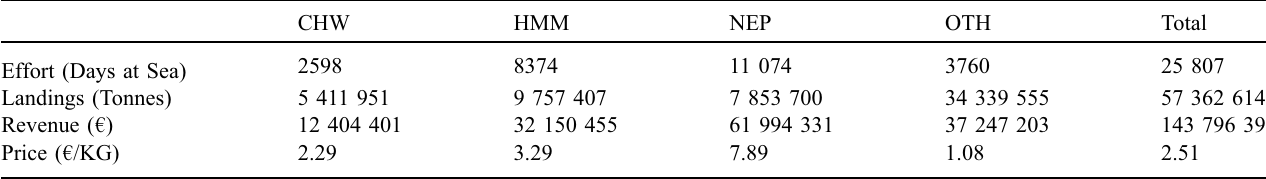
Table 1. Summary statistics for the white fi sh fl eet by fi shery. CHW